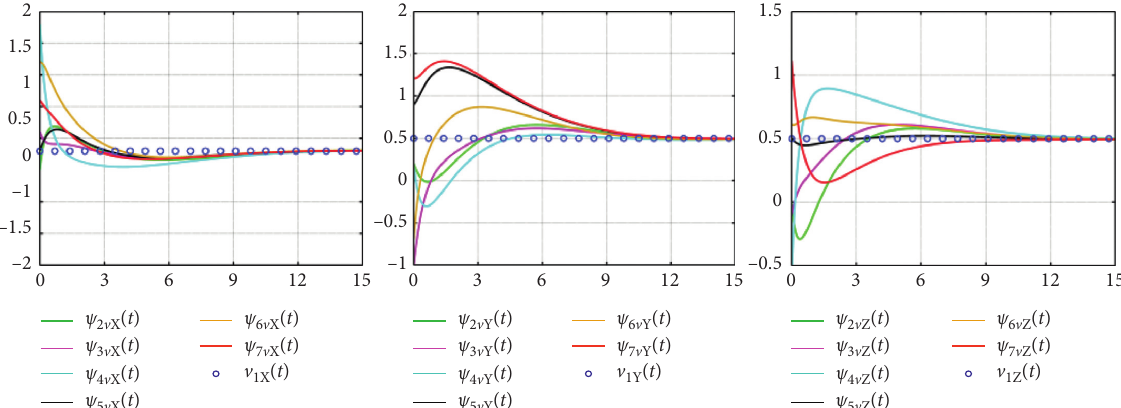
Figure 10: Trajectories of ψ